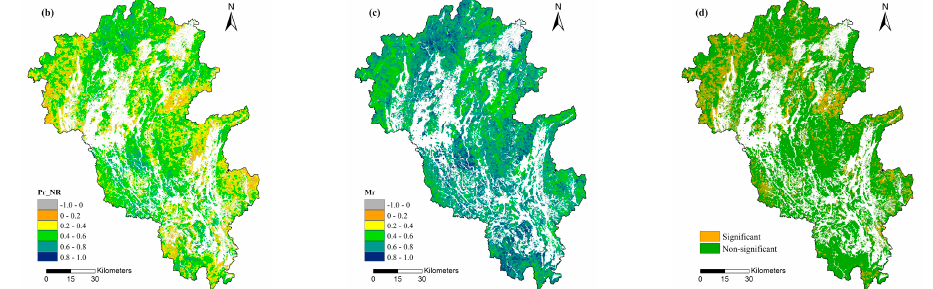
Figure 5. ( a ) Partial correlation coefficient of annual NDVI and precipitation; ( b ) partial correlation coefficient of annual NDVI and net radiation; ( c ) multiple linear correlation coefficient (Mr) of annual NDVI with precipitation and net radiation; ( d ) significance of multiple linear regression.